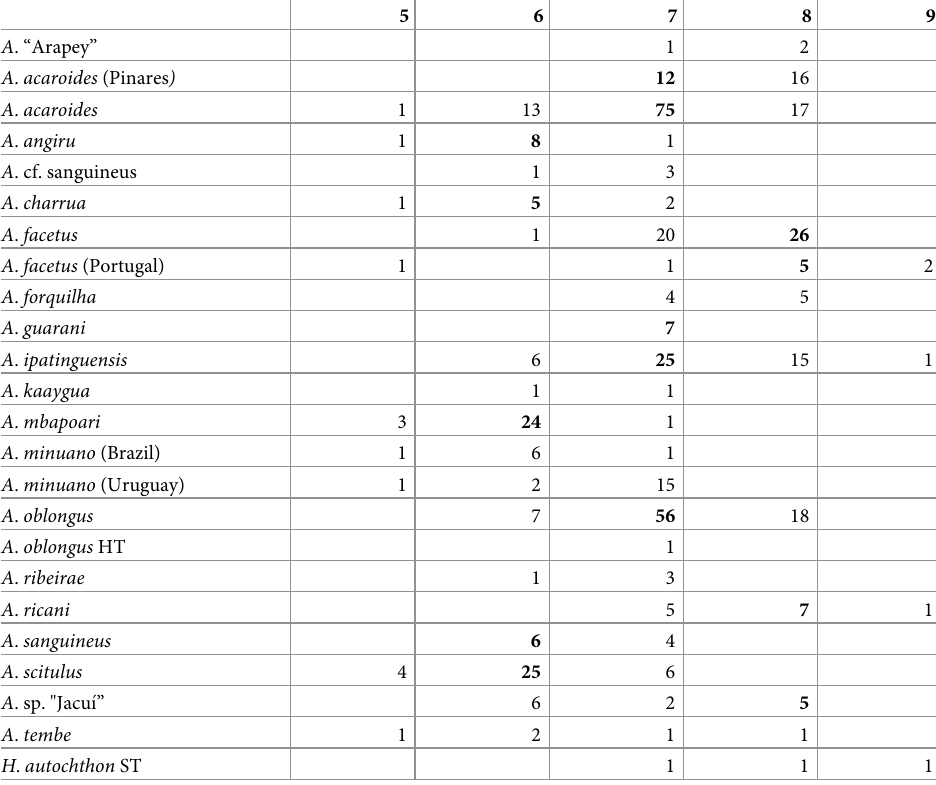
Table 9. Counts of ceratobranchial gill rakers in species of Australoheros .